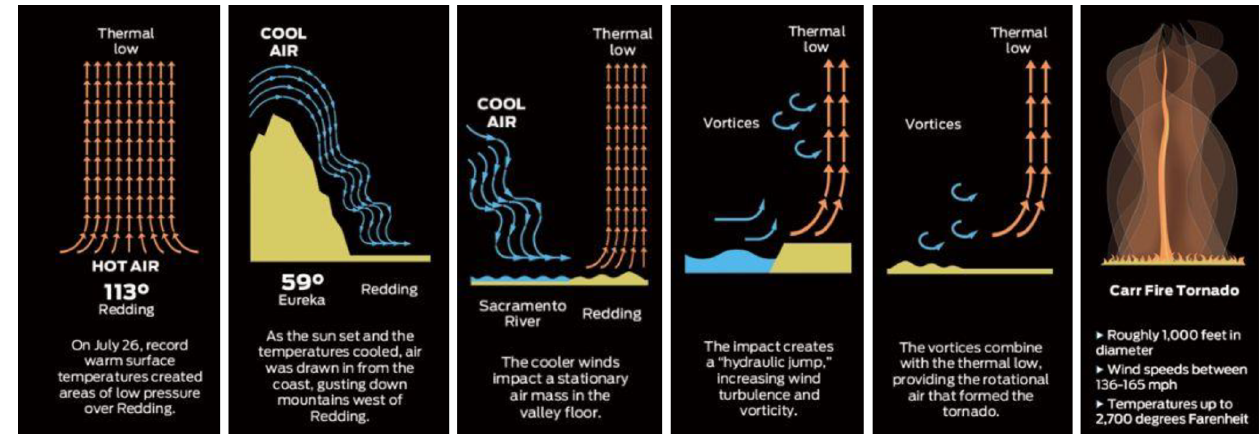
Figure 3. How the fire tornado formed (snapshots from an animation, Johnson,